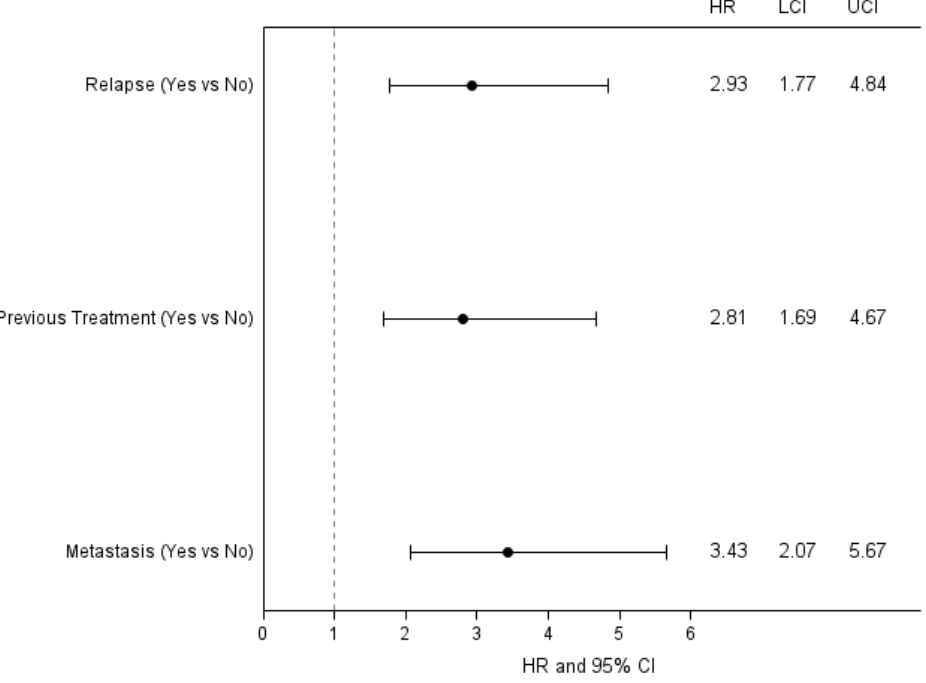
Figure 3. Overall Survival (OS) curves in patients with and without complications; mo = months.